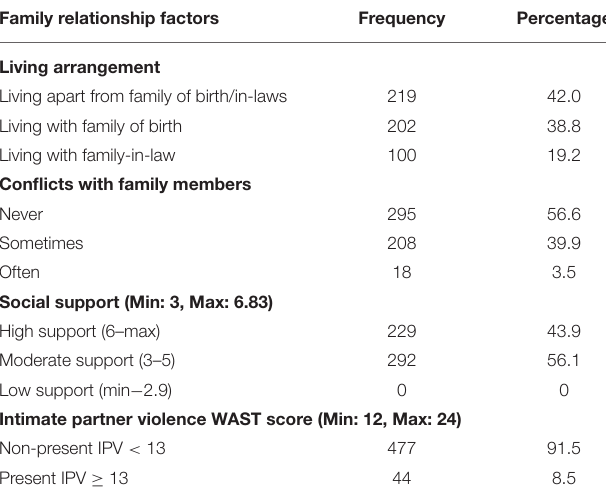
TABLE 2 | Family relationship characteristics of participants.